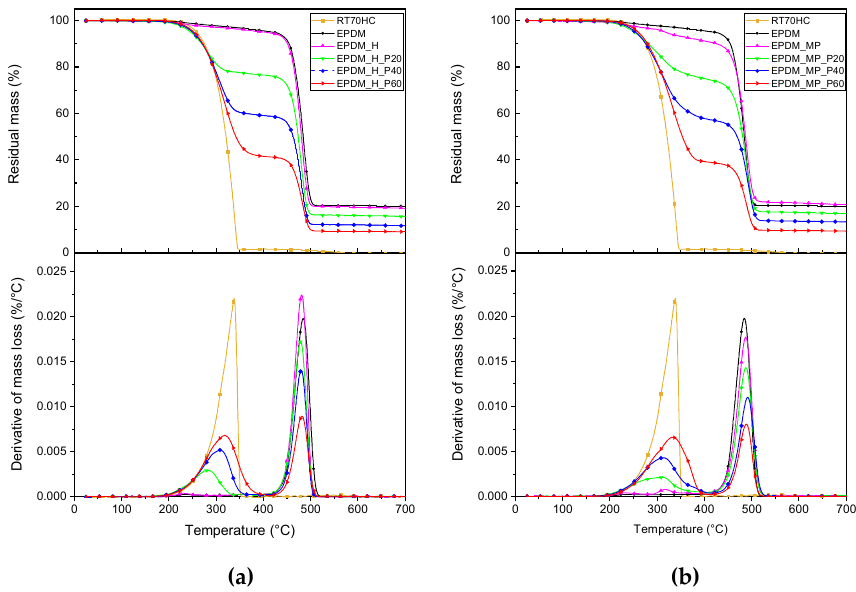
Figure 3. TGA thermograms (residual mass and mass loss derivative as a function of temperature) of bulk EPDM sample, neat paraffin (RT70HC), and foams produced with ( a ) H and ( b ) MP foaming agents. Table 6. Results of the TGA tests on bulk EPDM sample, neat paraffin (RT70HC), and the prepared foams.